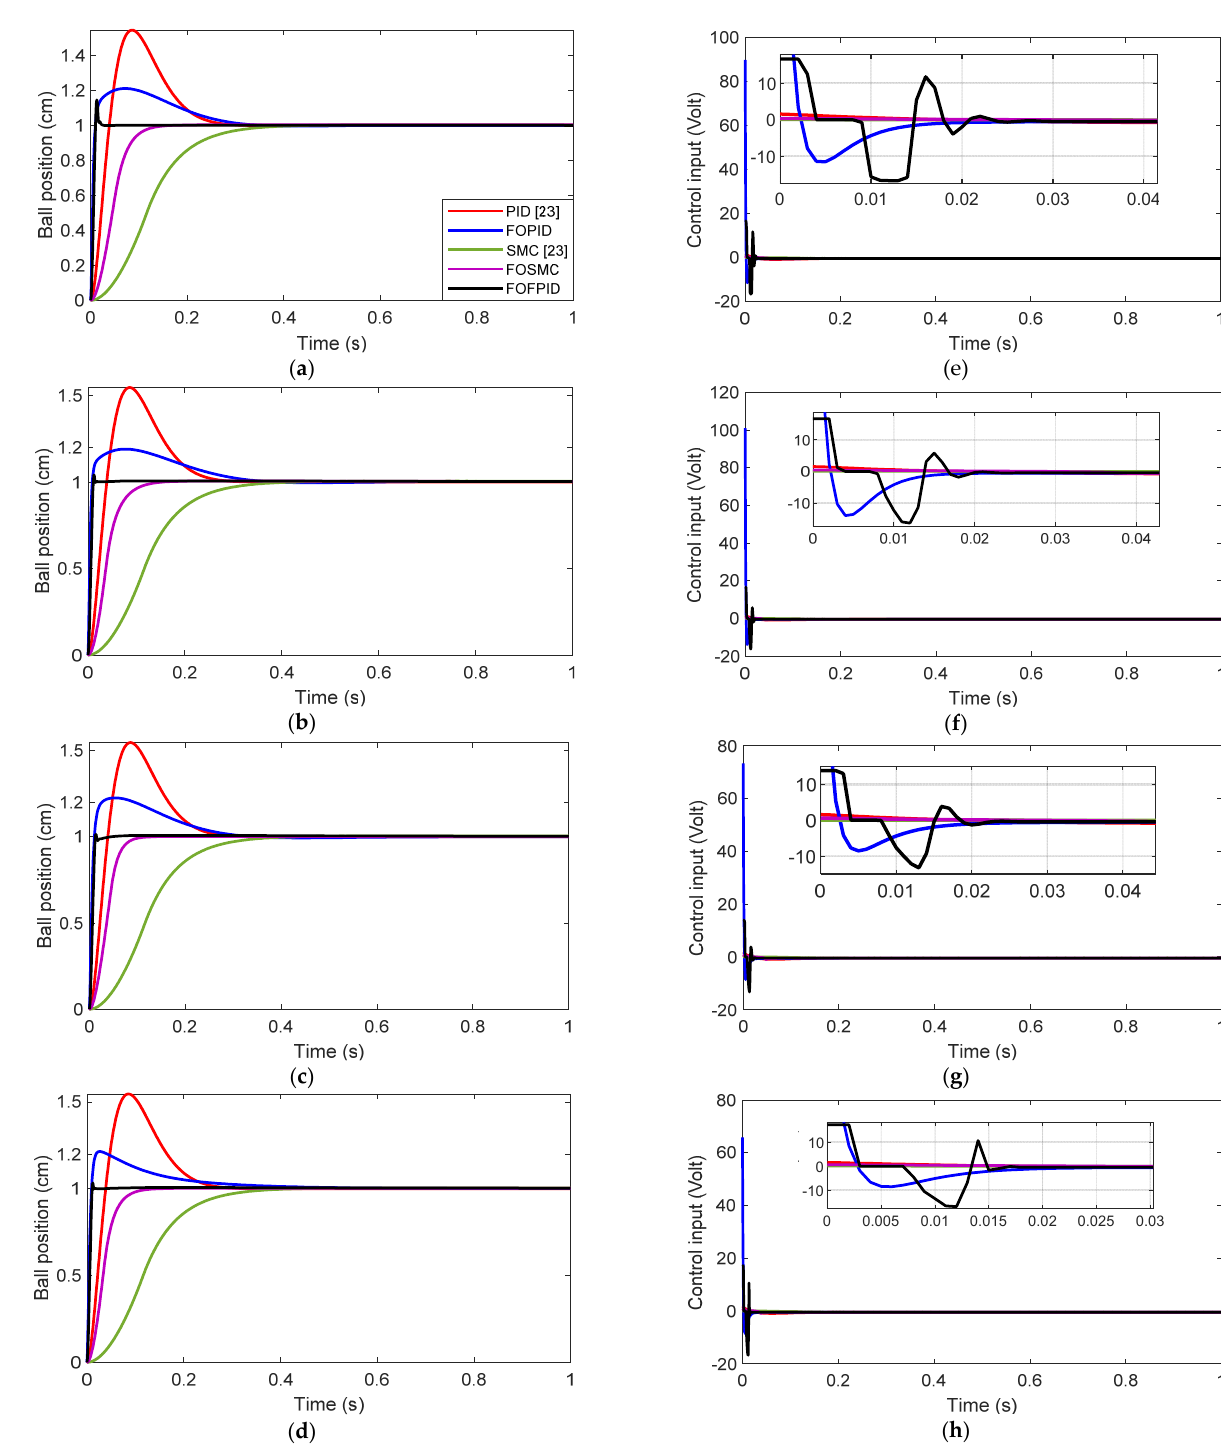
Figure 9. Closed-loop responses ( a – d ) and control efforts ( e – h ) for the Maglev system with different controllers based on J IAE ( a , e ), J ISE ( b , f ), J ITAE ( c , g ) and J ITSE ( d , h ) under parametric variation with −